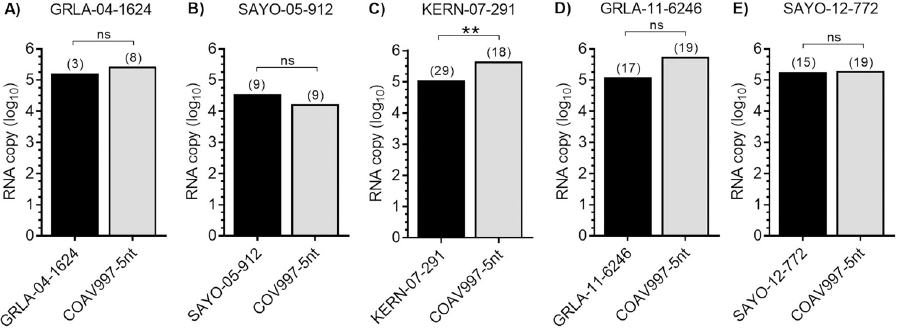
Fig 2. RNA copy numbers in bodies of infected Cx . tarsalis . Panels A to E show the average number of RNA copies within each competition group for outbreak isolates (black bars) and COAV997-5nt (grey bars) quantified by qRT-PCR in the bodies of singly and dually infected mosquitoes at 14 dpi. Number of samples is shown at the top of each column in parentheses. Statistical significance is indicated as “ns” for P > 0.05 and double asterisk for P � 0.01 as determined by Mann-Whitney